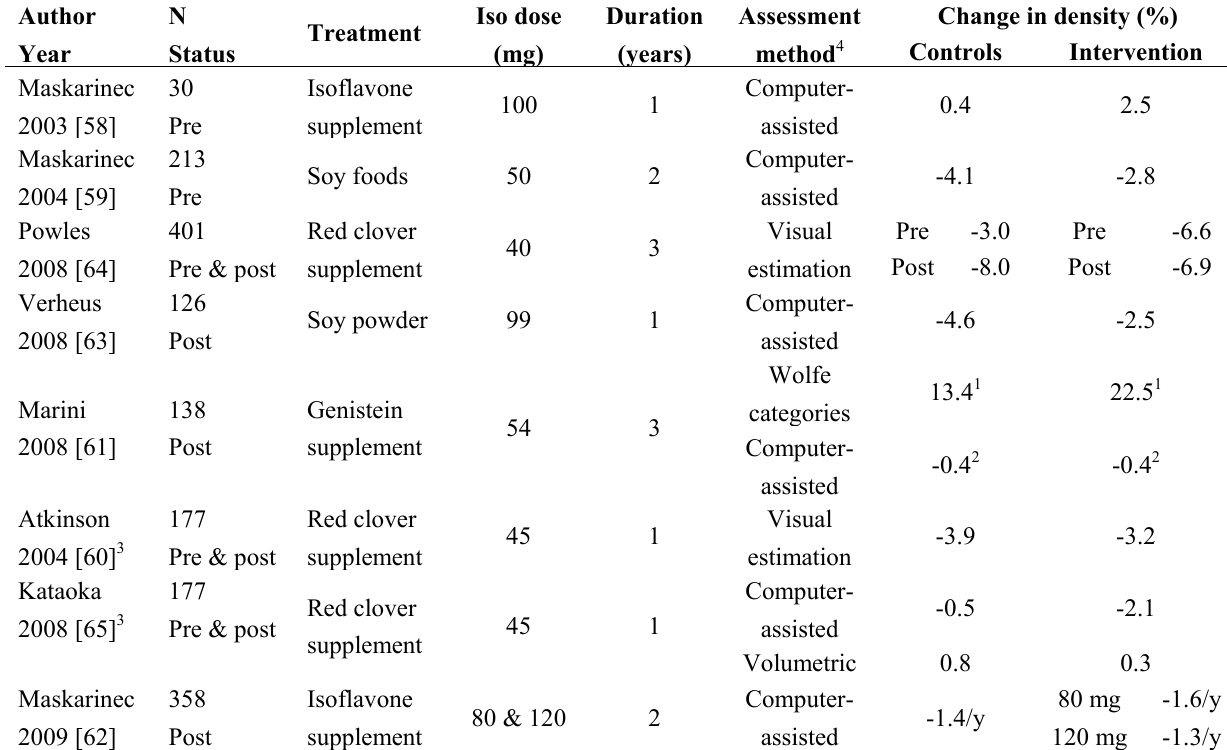
Table 2. Randomized trials with soy/isoflavones and breast density as